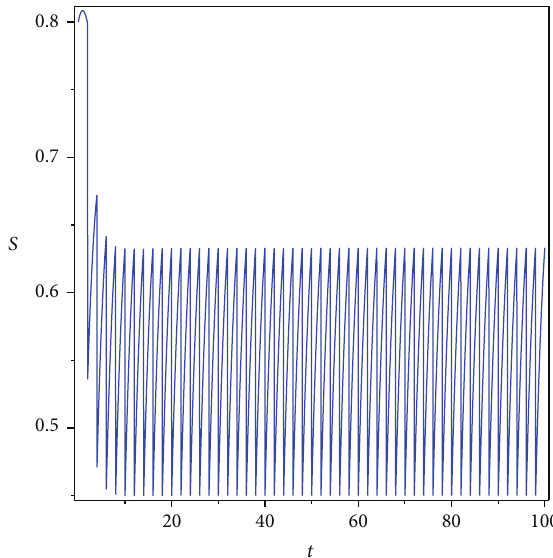
Figure 5: Time series of 𝑆 of system (42) while 𝜃 = 0.9 .